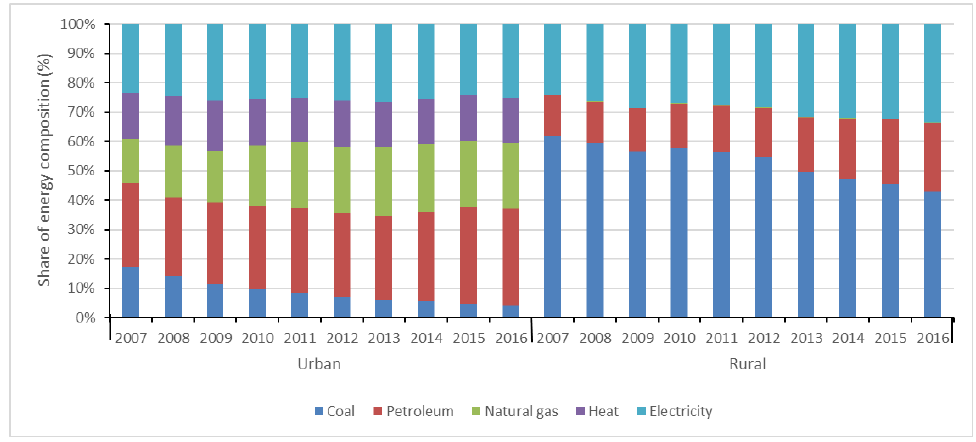
Figure 3. Changes of residential energy consumption structure in urban and rural China.